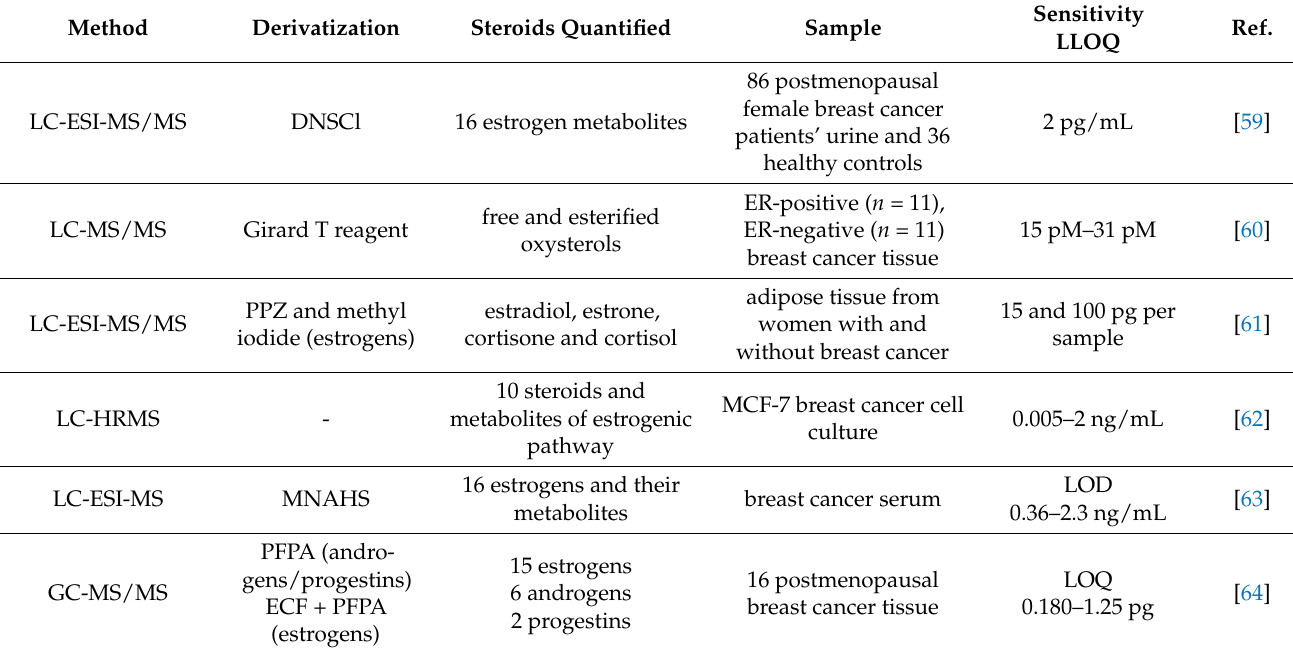
Table 1. Outline of analytical strategies based on steroidomics as tools in breast cancer